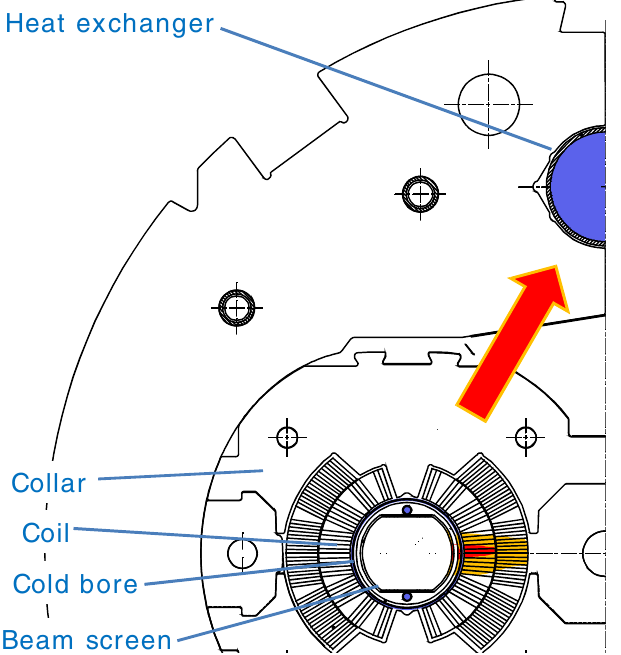
FIG. 11. (Color) The power deposition in each strand of the superconducting coil in the 5 cm-longitudinal cell where it assumes its maximum value, as interpolated from the result of the FLUKA simulation.